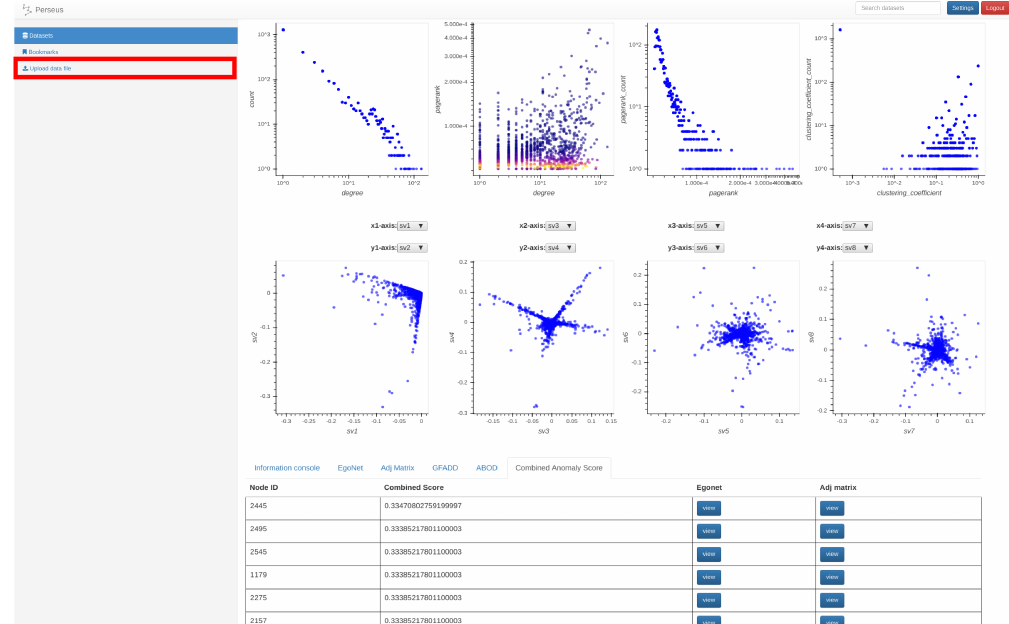
Figure 2. P ERSEUS -H UB ‘user’ view: Node statistic distribution and correlation plots summarize the key structural properties of the input graph, and provide the user with an initial point for exploration and in-depth analysis. The red box annotation indicates the tab for uploading input graph